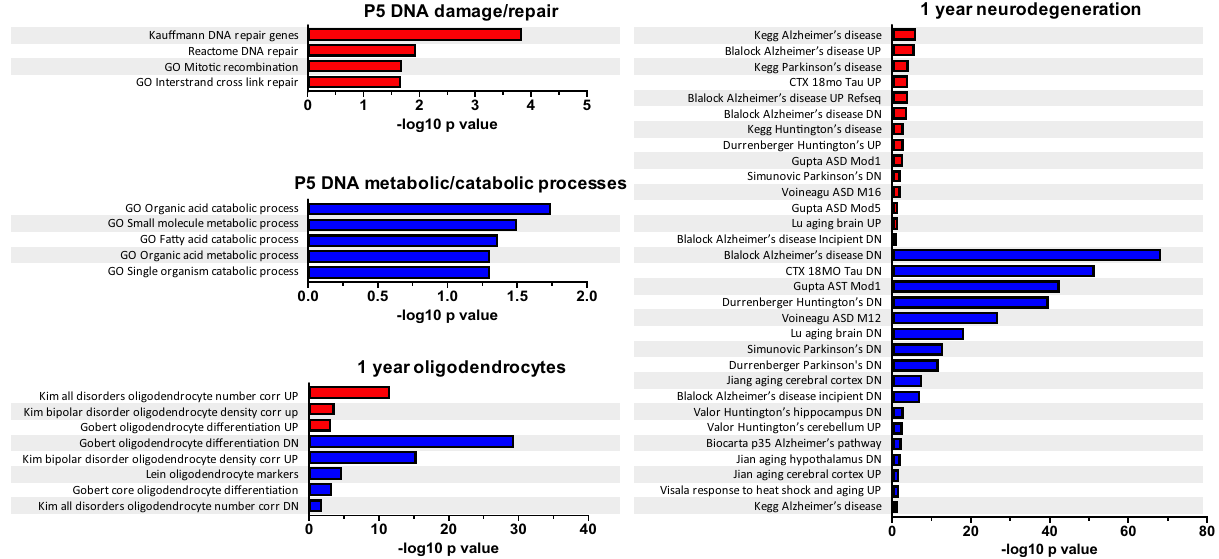
Figure 6. Summary of select upregulated and downregulated pathways in oil-exposed Chd8 V986*/ + mice . Data derived from bulk RNA-sequencing analysis of cortical tissue from PND 5 (P5) and 1 year old Chd8 V986*/ + mice compared to WT control. Bar graphs represent the significance of pathways in four